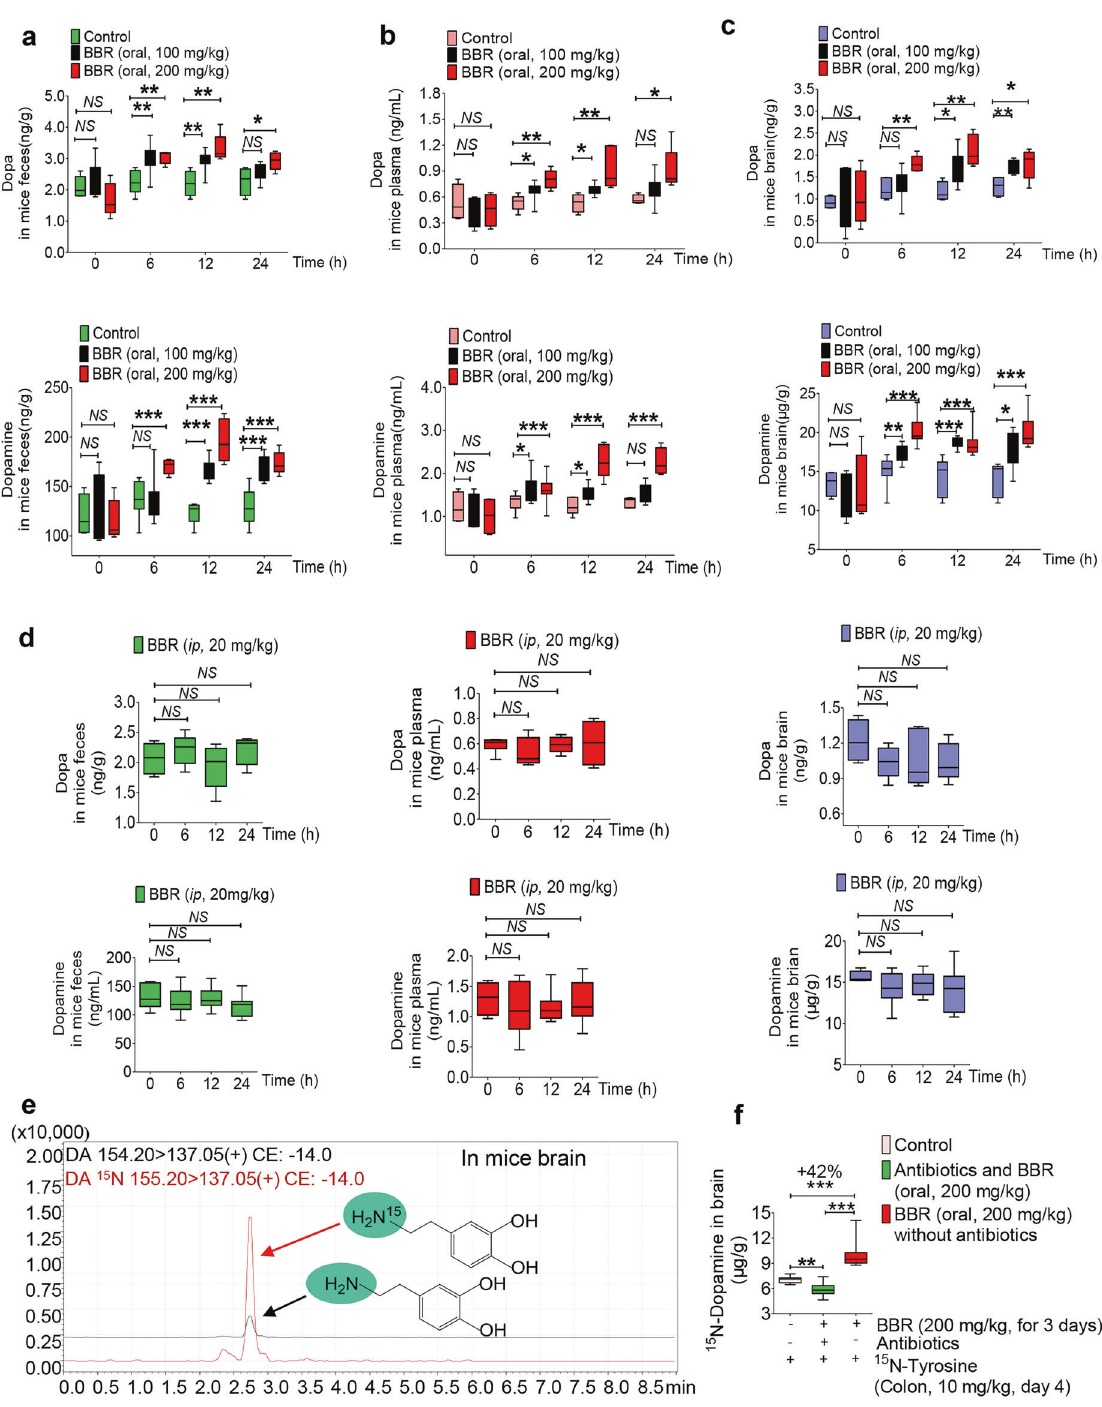
Fig. 1 BBR increased dopa/dopamine production in the gut microbiota in vivo. a Dopa/dopamine signi fi cantly increased in the feces of ICR mice at 0, 6, 12, and 24 h after oral administration of BBR (100 and 200 mg/kg, respectively; mean ± SD, * P < 0.05, ** P < 0.01 for dopa and *** P < 0.001 for dopamine). b Dopa/dopamine showed a dose- and time-dependent increase in plasma after BBR treatment (mean ± SD, * P < 0.05 and ** P < 0.01 for dopa; * P < 0.05, *** P < 0.001 for dopamine). c Dopa/dopamine showed a similar dose- and time-dependent increase in the brain after BBR treatment (mean ± SD, * P < 0.05 and ** P < 0.01 for dopa; * P < 0.05, ** P < 0.01, and *** P < 0.001 for dopamine). d Intraperitoneal injection (i.p.) of BBR into the ICR mice did not increase the levels of dopa/dopamine in the feces, plasma, and brain at any of the study time points, which was different from the results of BBR in oral administration (mean ± SD, NS no signi fi cance). e Mass spectra of 15 N-dopamine and dopamine in mouse brains. f Intestinal 15 N-Tyr was the raw material for the synthesis of 15 N-dopamine in brain. Pretreating the mice with antibiotics for 3 days attenuated the effect of BBR on 15 N-dopamine production (mean ± SD, ** P < 0.01, *** P < 0.001), and oral administration of BBR signi fi cantly increased 15 N-dopamine in the brain (* P <